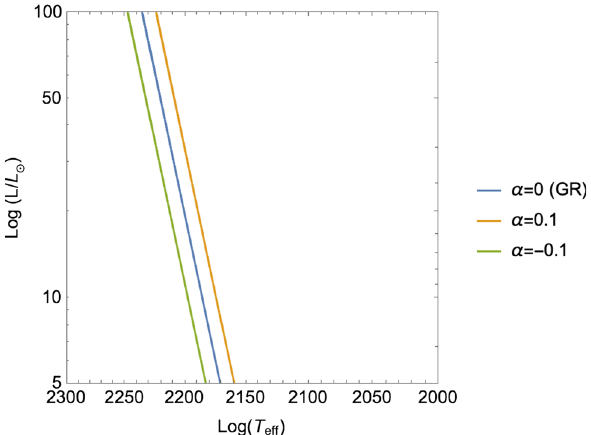
Fig. 1 The piece of the HR diagram representing shifted Hayashi tracks by the modifications introduced by EiBI gravity model in loga- rithmicscale.ThecurvesaregivenbytheEq.(50)taking M / M (cid:2) = 1 / 2, for some chosen values of the parameter α defined in Eq. (18) as com- pared to the GR/Newtonian curve, α =